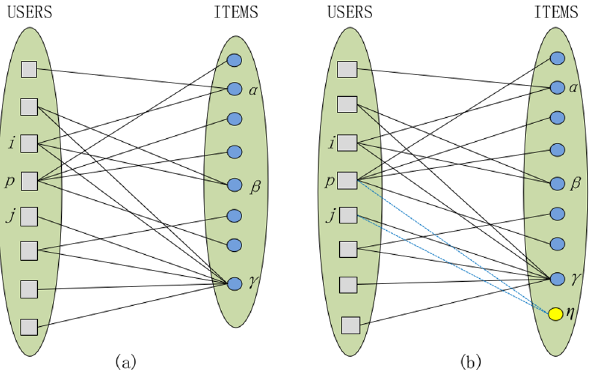
Figure 1. How to add a cold-start item to the user-item bipartite network. Users and items are represented by squares and circles respectively, and solid lines represent the existent links between them. Plot (a) is the original network, and plot (b) is the network after adding the item g (the yellow circle). The dotted lines are new links connecting g with two existent users.